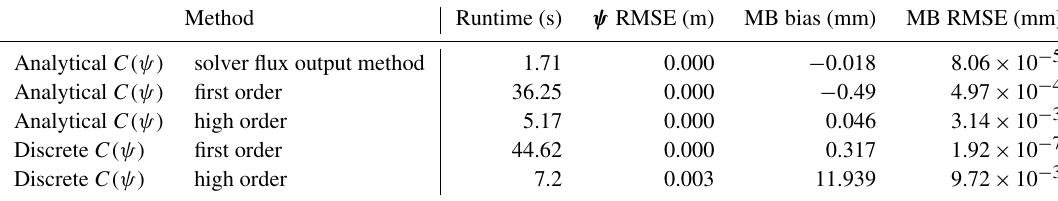
Table A3. Model performance using different approaches to calculate C(ψ) .